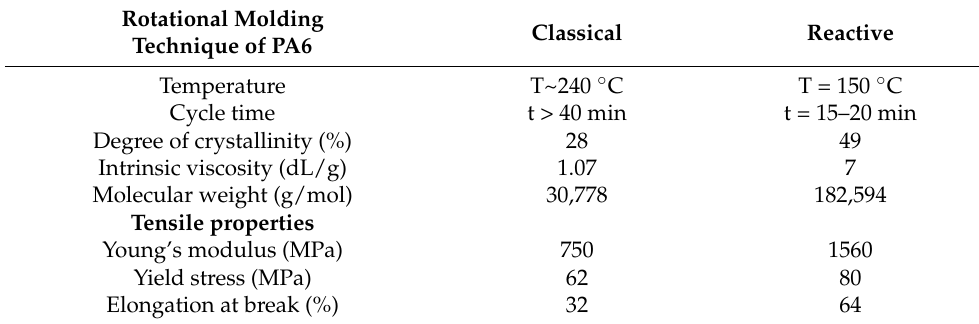
Table 1. Material characteristics and processing parameters when comparing classical versus reactive processing. Adapted from Reference